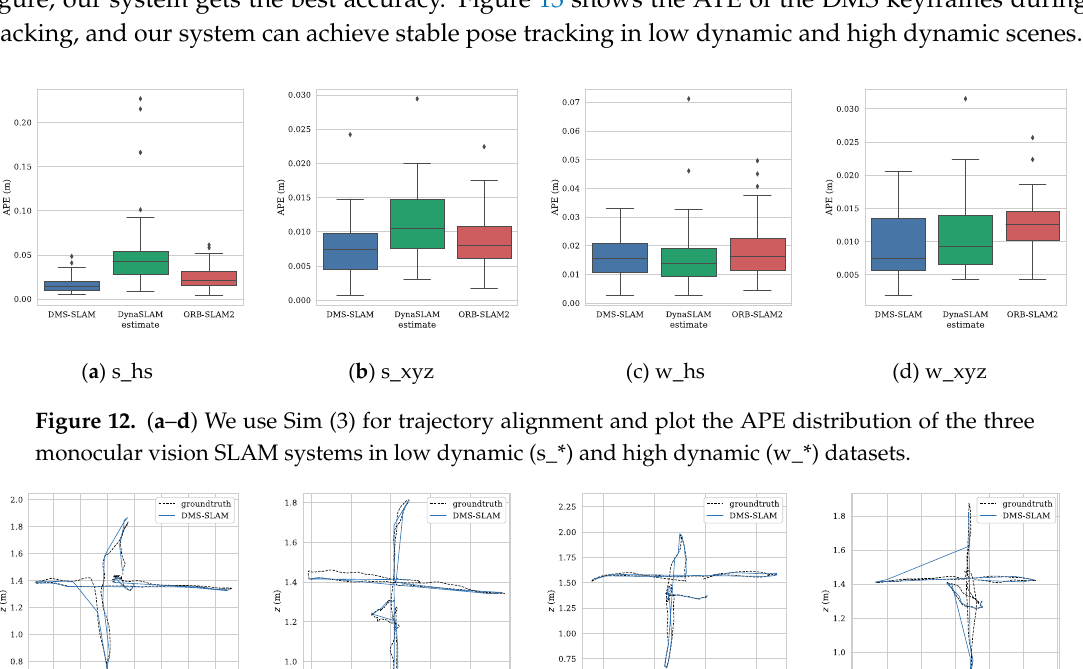
Table 3. Accuracy, speed and TCR in low dynamic scenes (s_*) and high dynamic scenes (w_*). Datasets